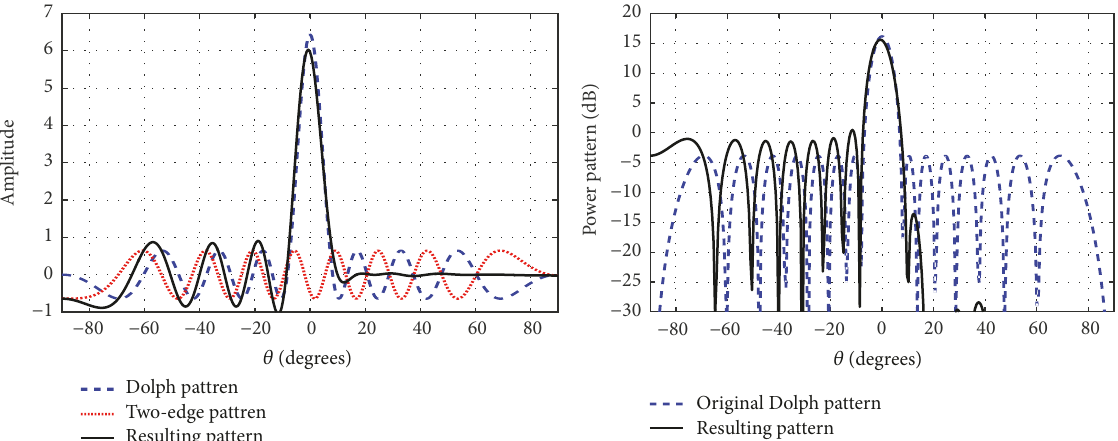
Figure 2: Radiation patterns of the original Dolph-Chebyshev array and the proposed arrays for 𝑁 = 16 , 𝑑 = 𝜆/2 , and 𝑃 = 9.1576 ∘